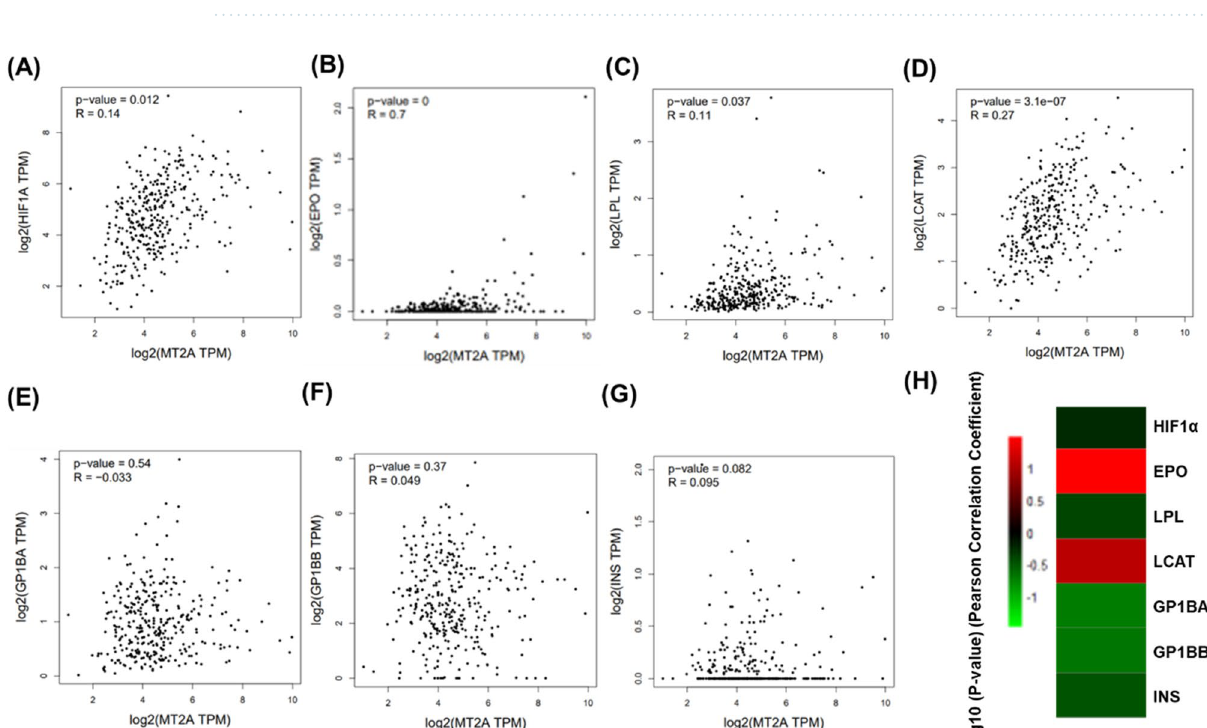
Figure 3. The direct correlation between RNA (TPM) in the whole blood tissue. ( A – F ) Pearson’s correlation elucidated the associations between HIF1α, EPO, LPL, LCAT, GP1BA, GP1BB INS, and MT2A mRNA expression, respectively. ( G ) Heatmap of Pearson’s correlations, shown by calculating (− log10 ( p value)) for HIF1α, EPO, LPL, LCAT, GP1BA, and GP1BB use with MT2A. ( H ) Heatmap of Pearson’s correlations, shown by calculating (−Log10( p -value)) for MT2A use with HIF1α, EPO, LPL, LCAT, GP1BA, GP1BB, and